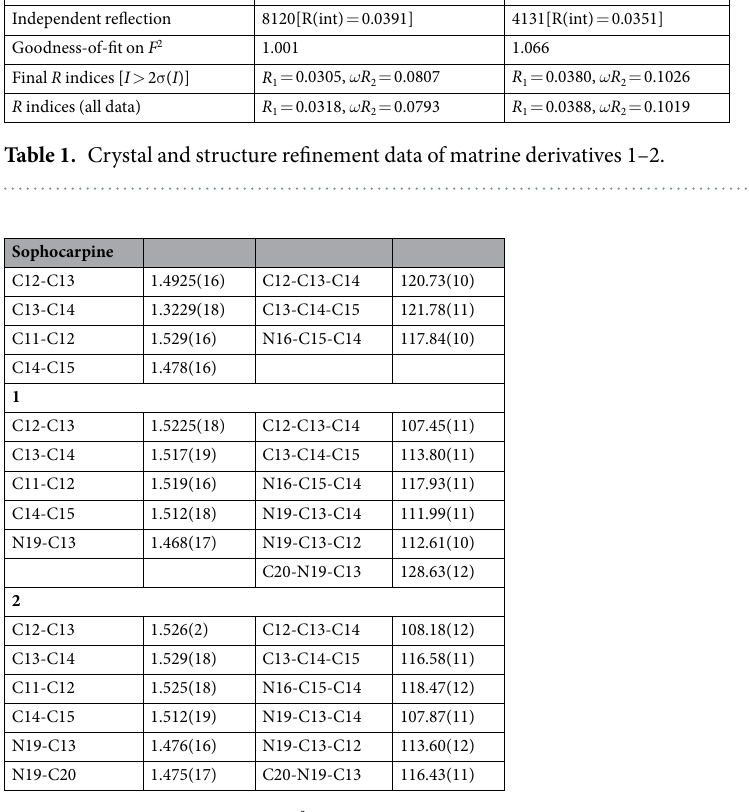
Table 2. Selected bond lengths (Å) and bond angles (°) of matrine derivatives